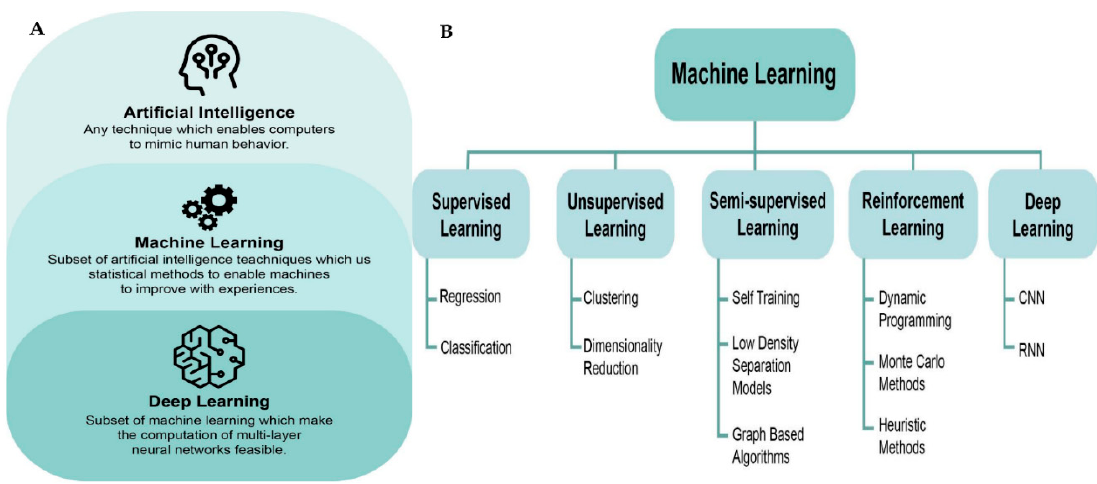
Figure 1. ( a ) Relationships between artificial intelligence, machine learning, and deep learning. ( b ) Types of machine learning. CNN, convolutional neural network; RNN, recurrent neural network.